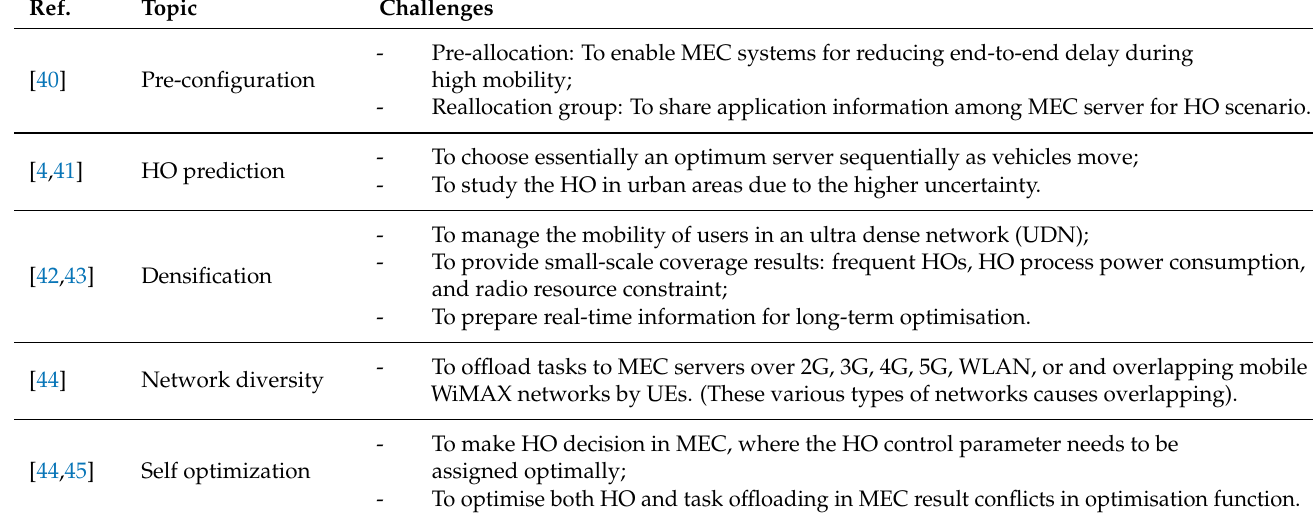
Table 1. Summary of mobility management challenges in MEC.